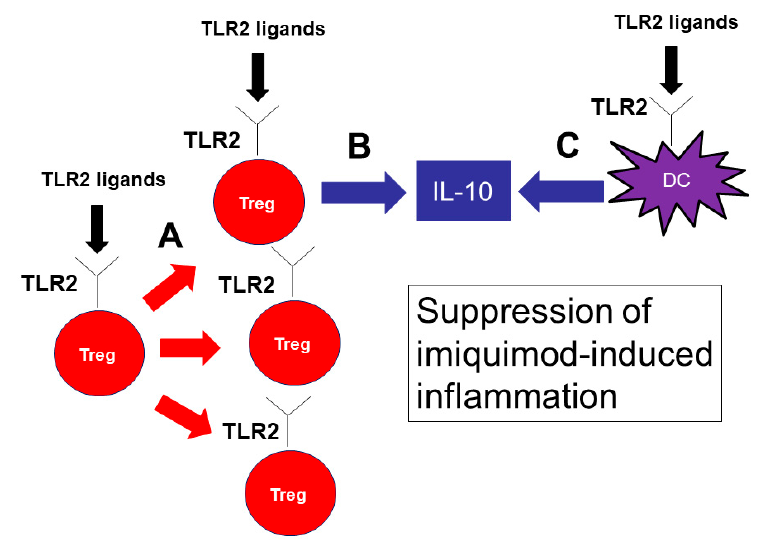
Figure 7. TLR2 signaling is important for the proliferation of Tregs and IL-10 production by Tregs and DCs, suppressing imiquimod-induced inflammation. TLR2 signaling is important for the proliferation of Tregs ( A ). TLR2 ligands also induce IL-10 production by Tregs ( B ) and DCs ( C ). IL-10 is the key cytokine to suppress imiquimod-induced inflammation.